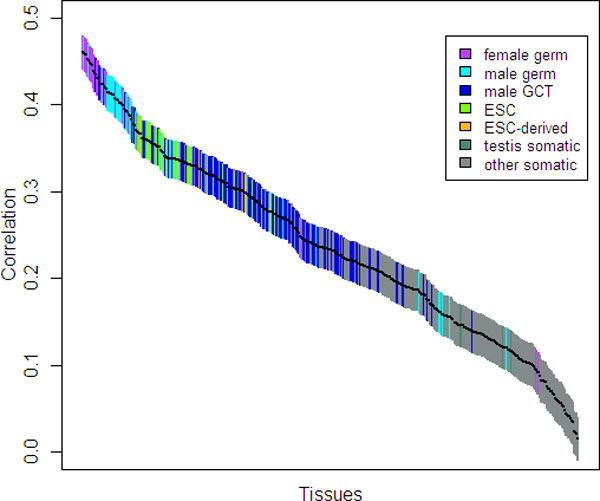
Pairwise correlations between gene expression and CpGO/E ratio in the promoter regions of genes with high tissue differentiation. Each of the 409 tissue samples is represented by a single bar. Color indicates one of the seven tissue types. GCT: germ cell tumors. ESC: embryonic stem cells. Bars are ordered from left to right by the correlation coefficient value, and their vertical extent indicates the 95% confidence interval.